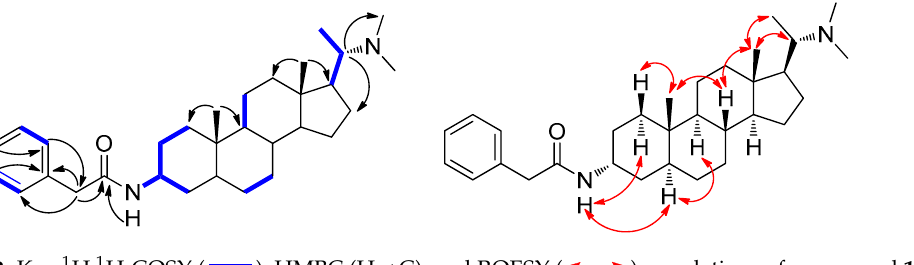
Figure 1. Structures of compounds 1 – 4 .